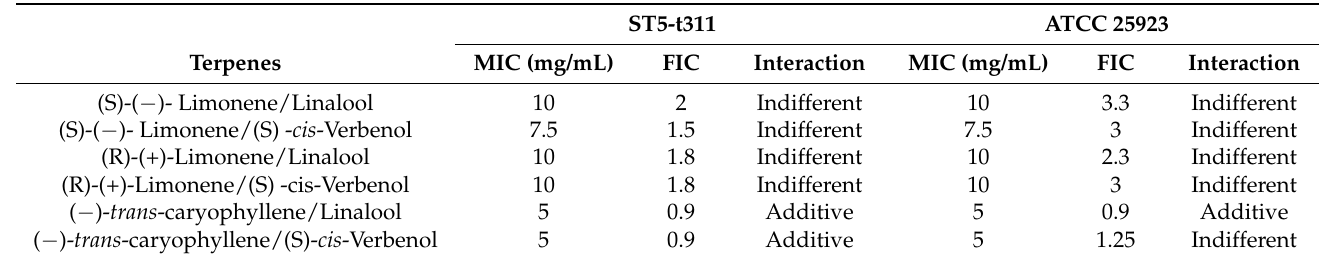
Table 2. Minimum inhibitory concentrations of terpenes